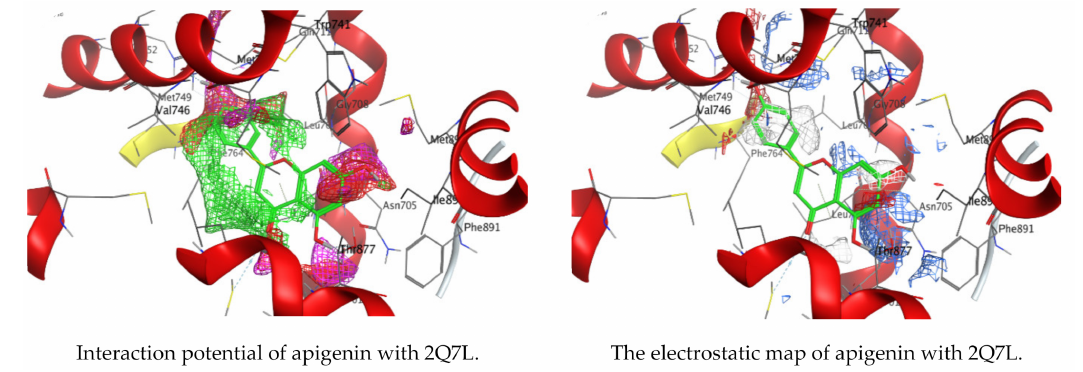
Figure 9. Molecular docking process of apigenin with 2Q7L protein. Table 5. Docking scores and energies of kaempferol and apigenin with prostate cancer (2Q7L) receptors.